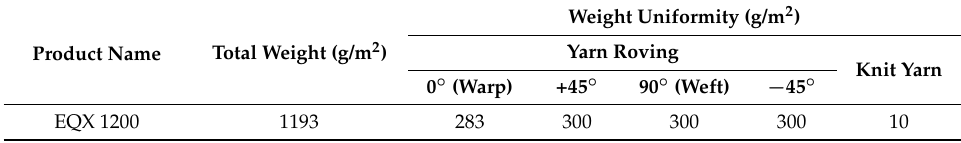
Table 2. Mechanical properties of GFRP laminates (supplied by the manufacturer).